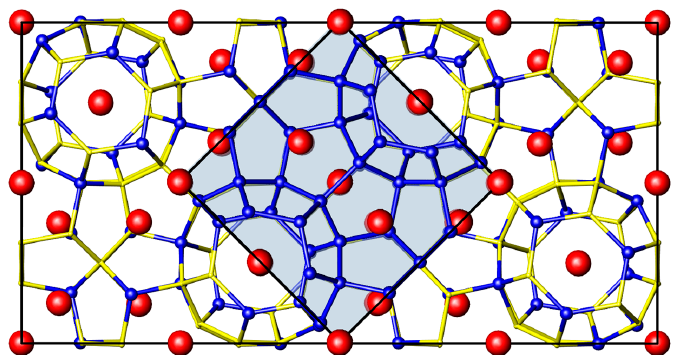
Figure 1. Clathrate-I unit cell of the large orthorhombic supercell with isolated M and P sites (blue, and yellow, respectively) and small cubic subcell (central blue square). Ba atoms are shown in red.